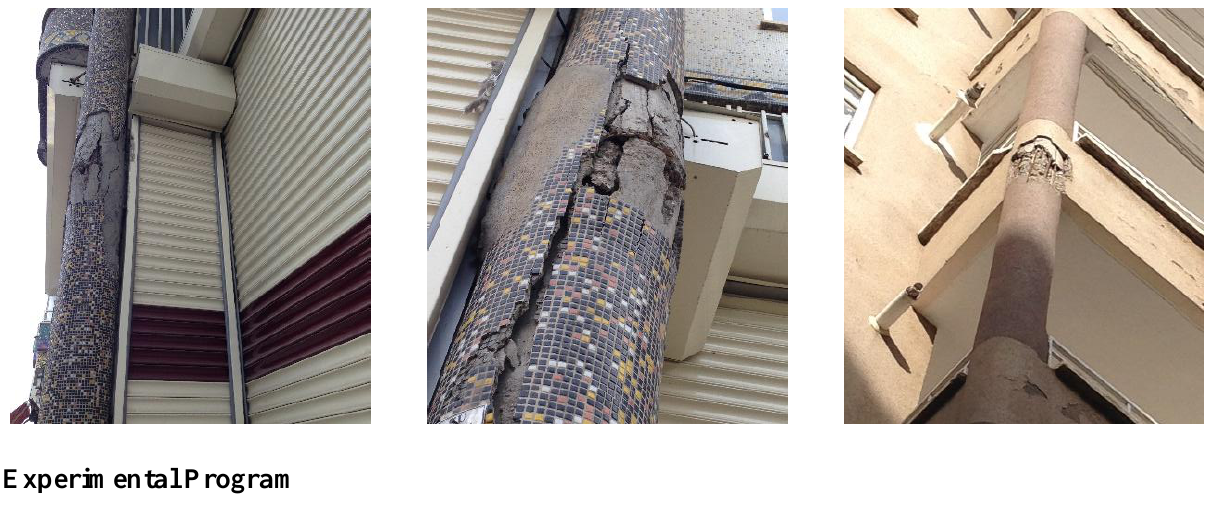
Figure 1. Columns damaged under sustained